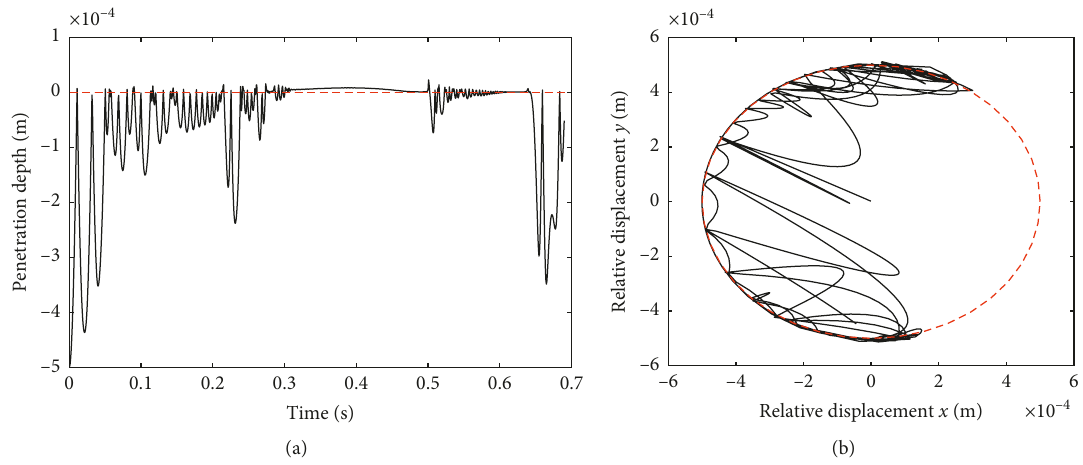
Figure 7: Penetration depth and shaft center trajectory: (a) penetration depth; (b) shaft center